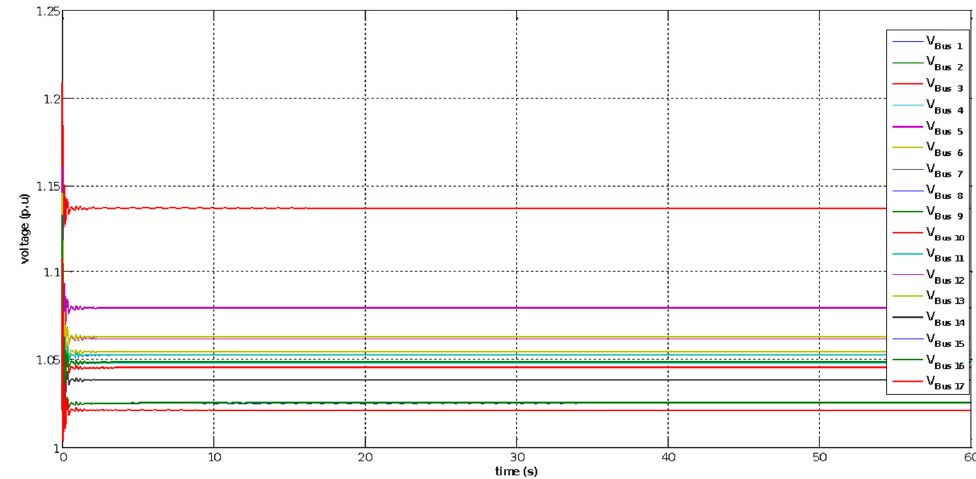
Figure 28. Response of the rotor angle at synchronous generators power plant at bus 1 and bus 3 during the base case.